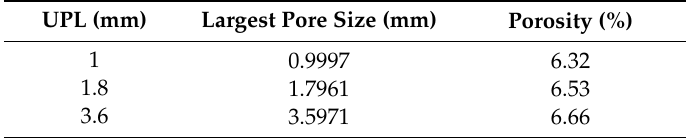
Table 3. Values of porosity calculated using various pore size limits